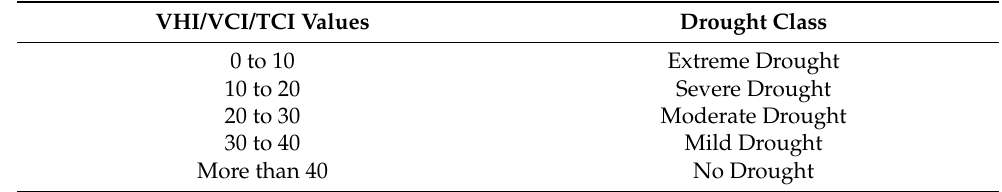
Table 3. Different drought categories for RSDIs (modified from